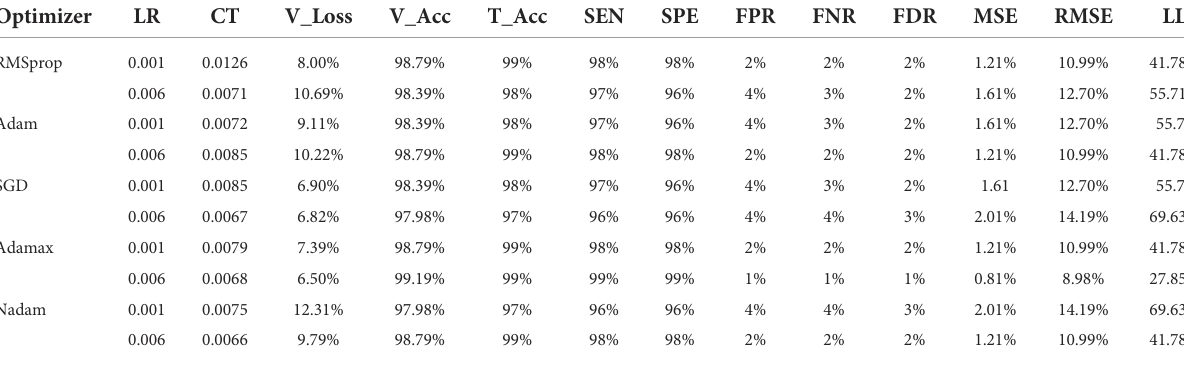
TABLE 6 A detailed comparison of testing accuracies among all the optimizers with different learning rates, comparison of the optimizers, and optimistic outcomes of various optimizers on the ISIC benign